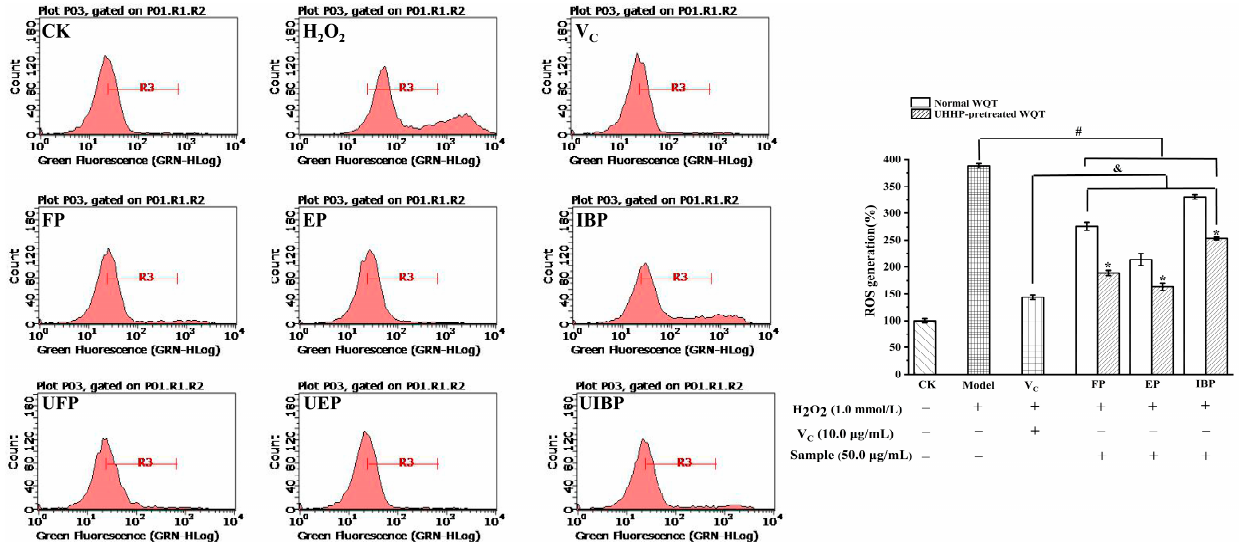
Figure 2. The inhibitory effects of intracellular ROS of the free, esterified, and insoluble-bound phenolic fractions from the normal and UHHP-pretreated White Que Zui tea (WQT) in H 2 O 2 -induced HepG2 cells. “*” indicated significant differences in the same fractions between the normal and UHHP-pretreated WQT ( p < 0.05); “#” indicated significant differences between the H 2 O 2 group and the sample groups ( p < 0.05); “&” indicated significant differences between the V C group and the sample groups ( p < 0.05). All the values were expressed as mean ± SD (n = 3). FP and UFP: free phenolic fraction from normal and UHHP-pretreated WQT; EP and UEP: esterified phenolic fraction from normal and UHHP-pretreated WQT; IBP and UIBP: insoluble-bound phenolic fraction from normal and UHHP-pretreated WQT.